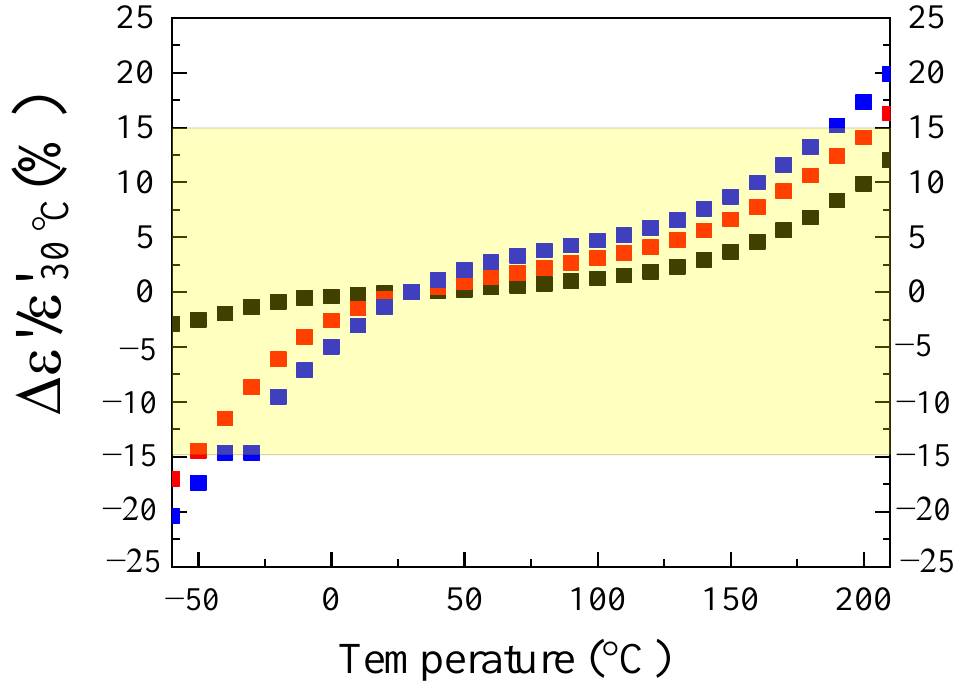
Figure 9. Temperature coefficient of ε’ at 1 kHz for all the ceramics.